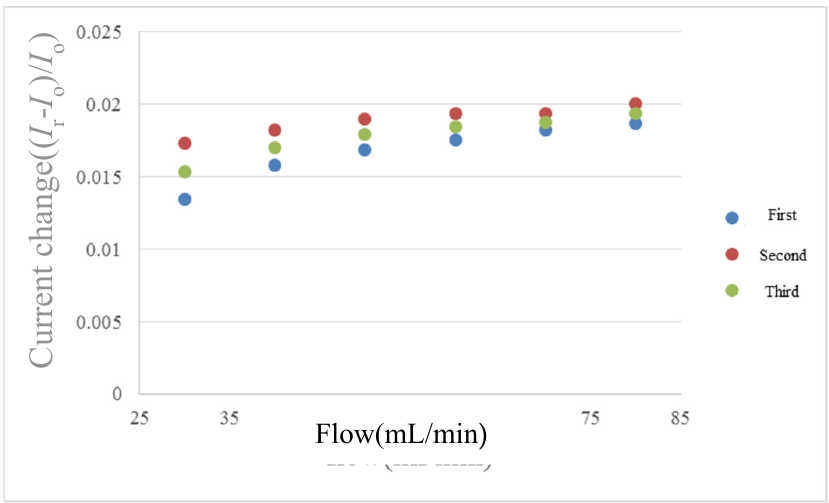
Figure 13. Micro flow sensor correction curve diagram.